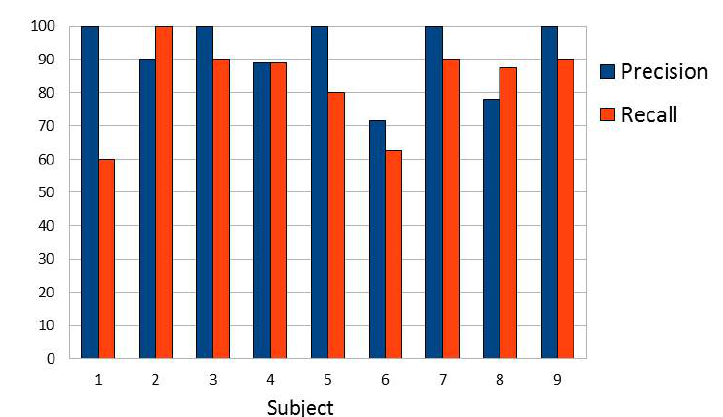
Figure 10. Statistics for different